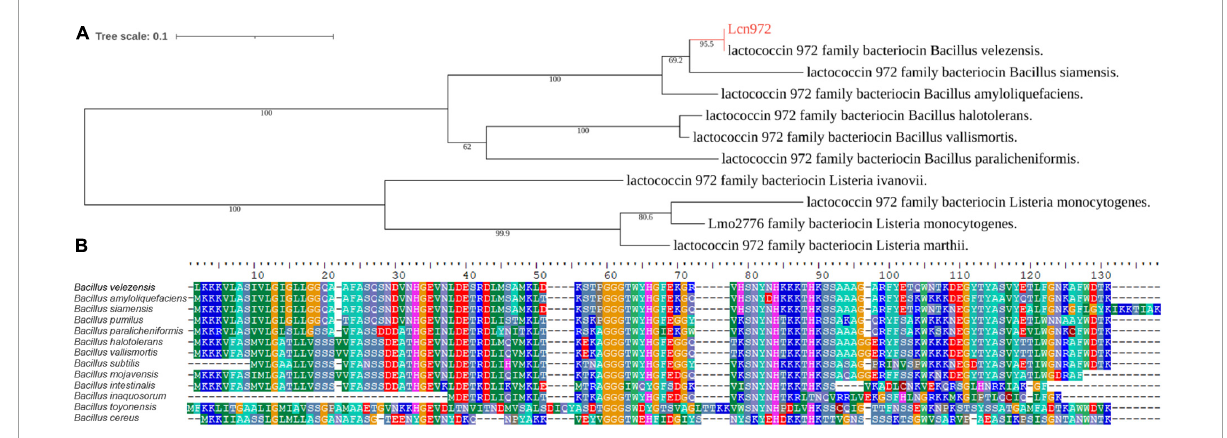
FIGURE1 Lcn972 secreted by Bacillus velezensis HN-Q-8. (A) Phylogenetic analysis of Lcn972; (B) comparison of the amino acid sequence of Lcn972 from B. velezensis HN-Q-8 with these of Lcn972 from other Bacillus